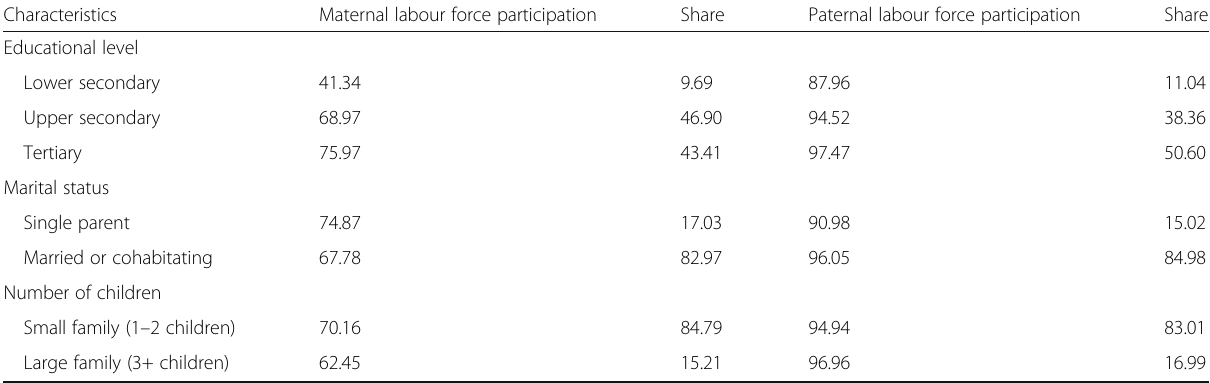
Table 1 Participation in the labour market according to individual and household characteristics